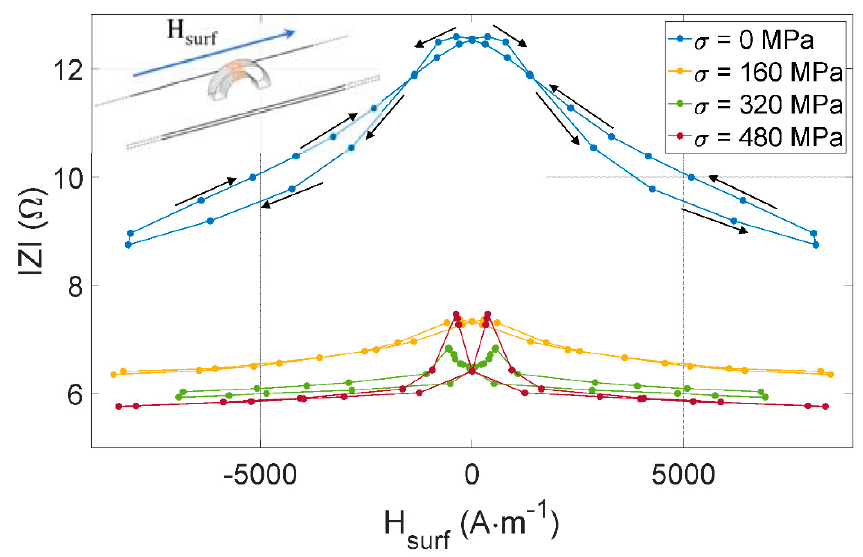
Figure 9. IZI(H surf ) for different tensile stress levels and with the MIP sensor aligned with the length of the tested specimen as illustrated in the top left-hand side